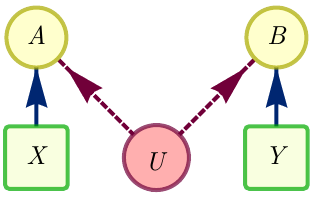
Figure 9: The Bell scenario. (Not a correlation scenario.)